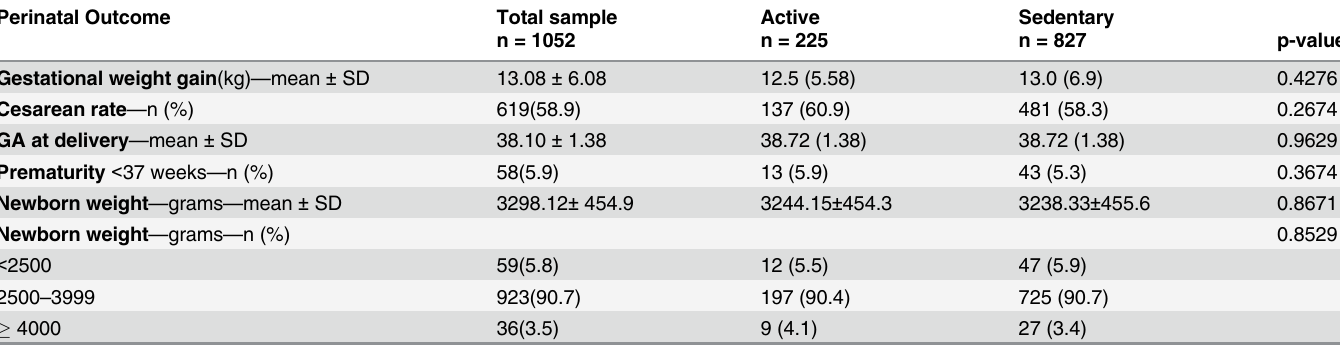
Table 5. Perinatal outcome according to physical activity during pregnancy (active or sedentary). Perinatal Outcome